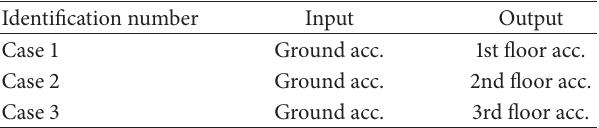
Table 3: Input and output signals for system identification.